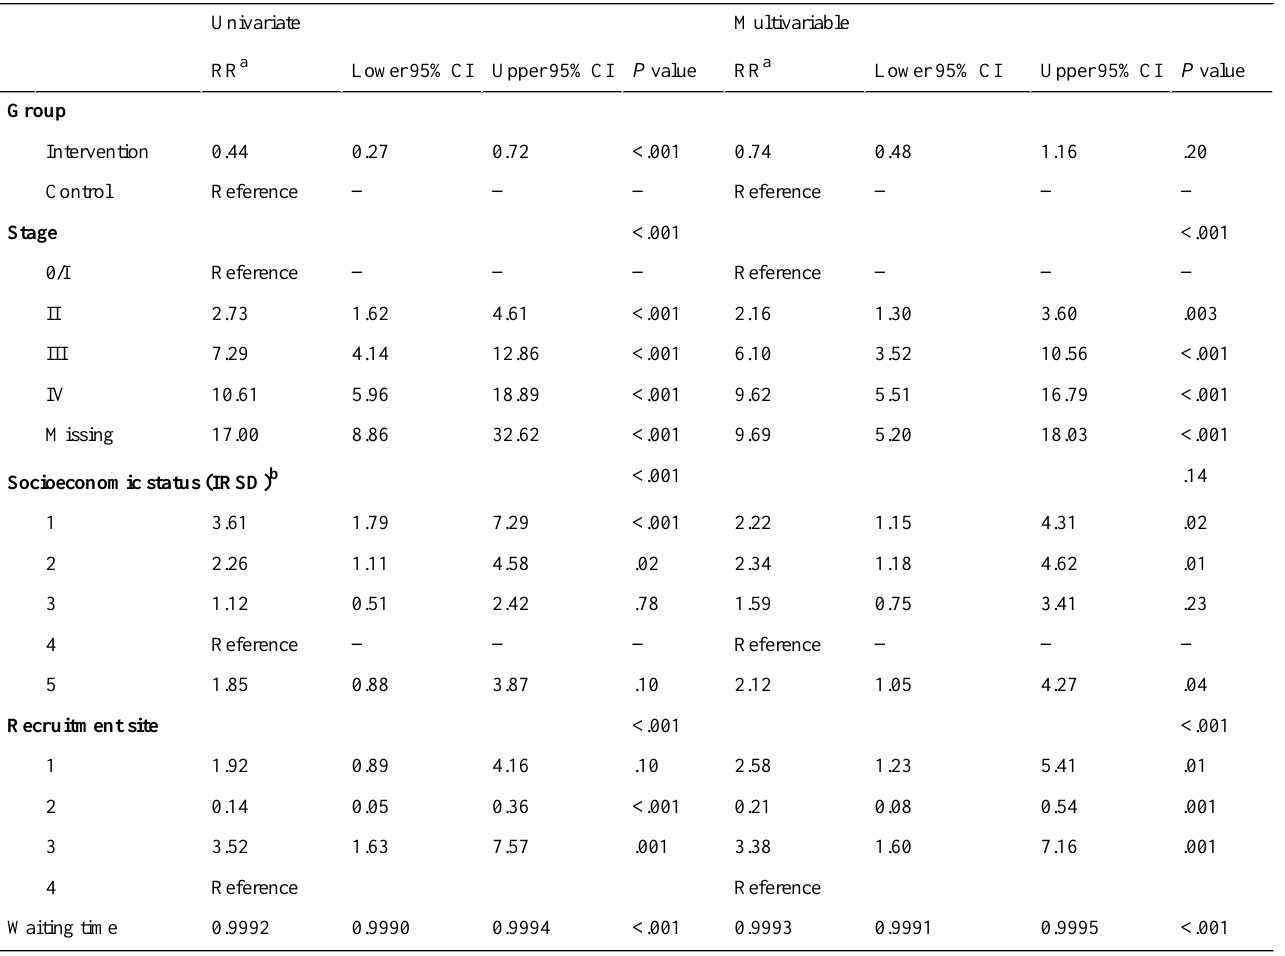
Table 3. Comparison of Allied Health referrals using negative binomial regression. Patients matched for age, sex, and treatment status.